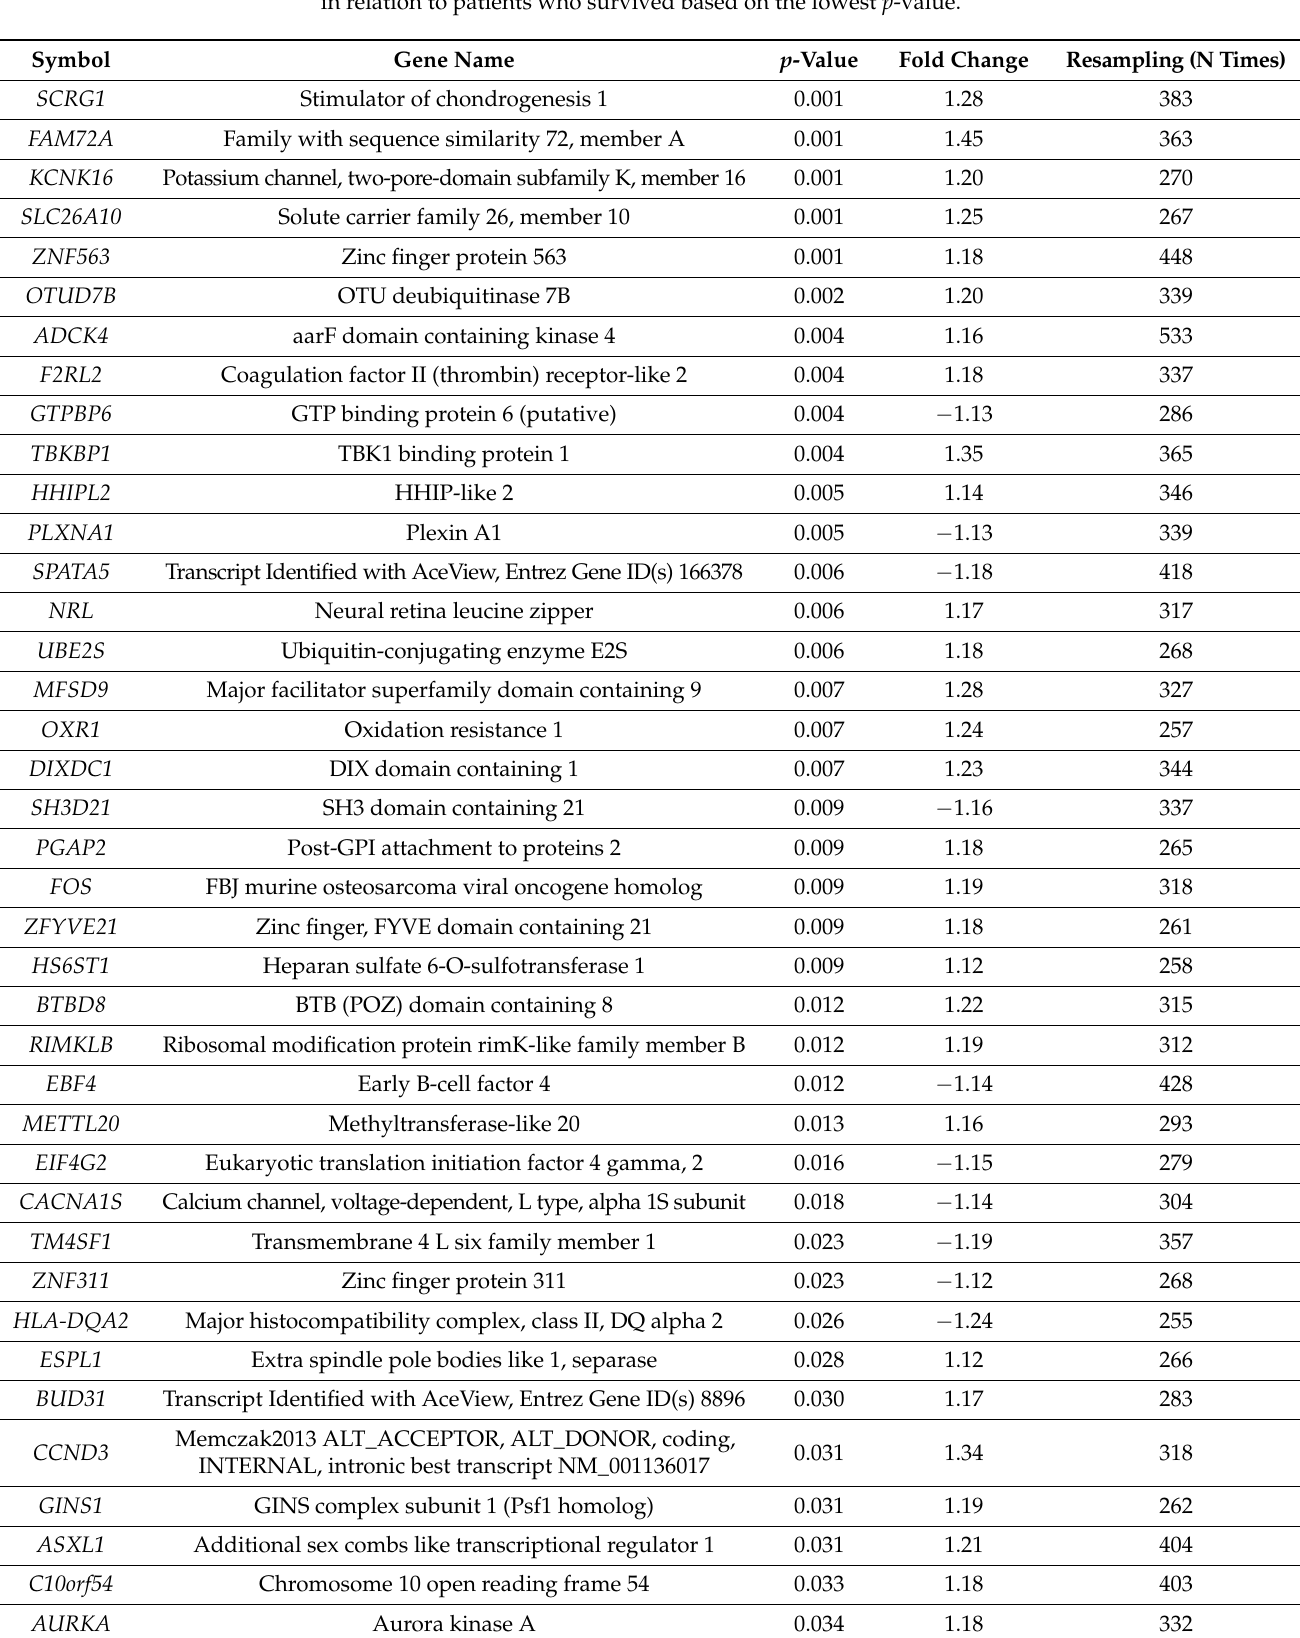
Table 2. List of genes differentially expressed in community-acquired pneumonia patients who died in relation to patients who survived based on the lowest p